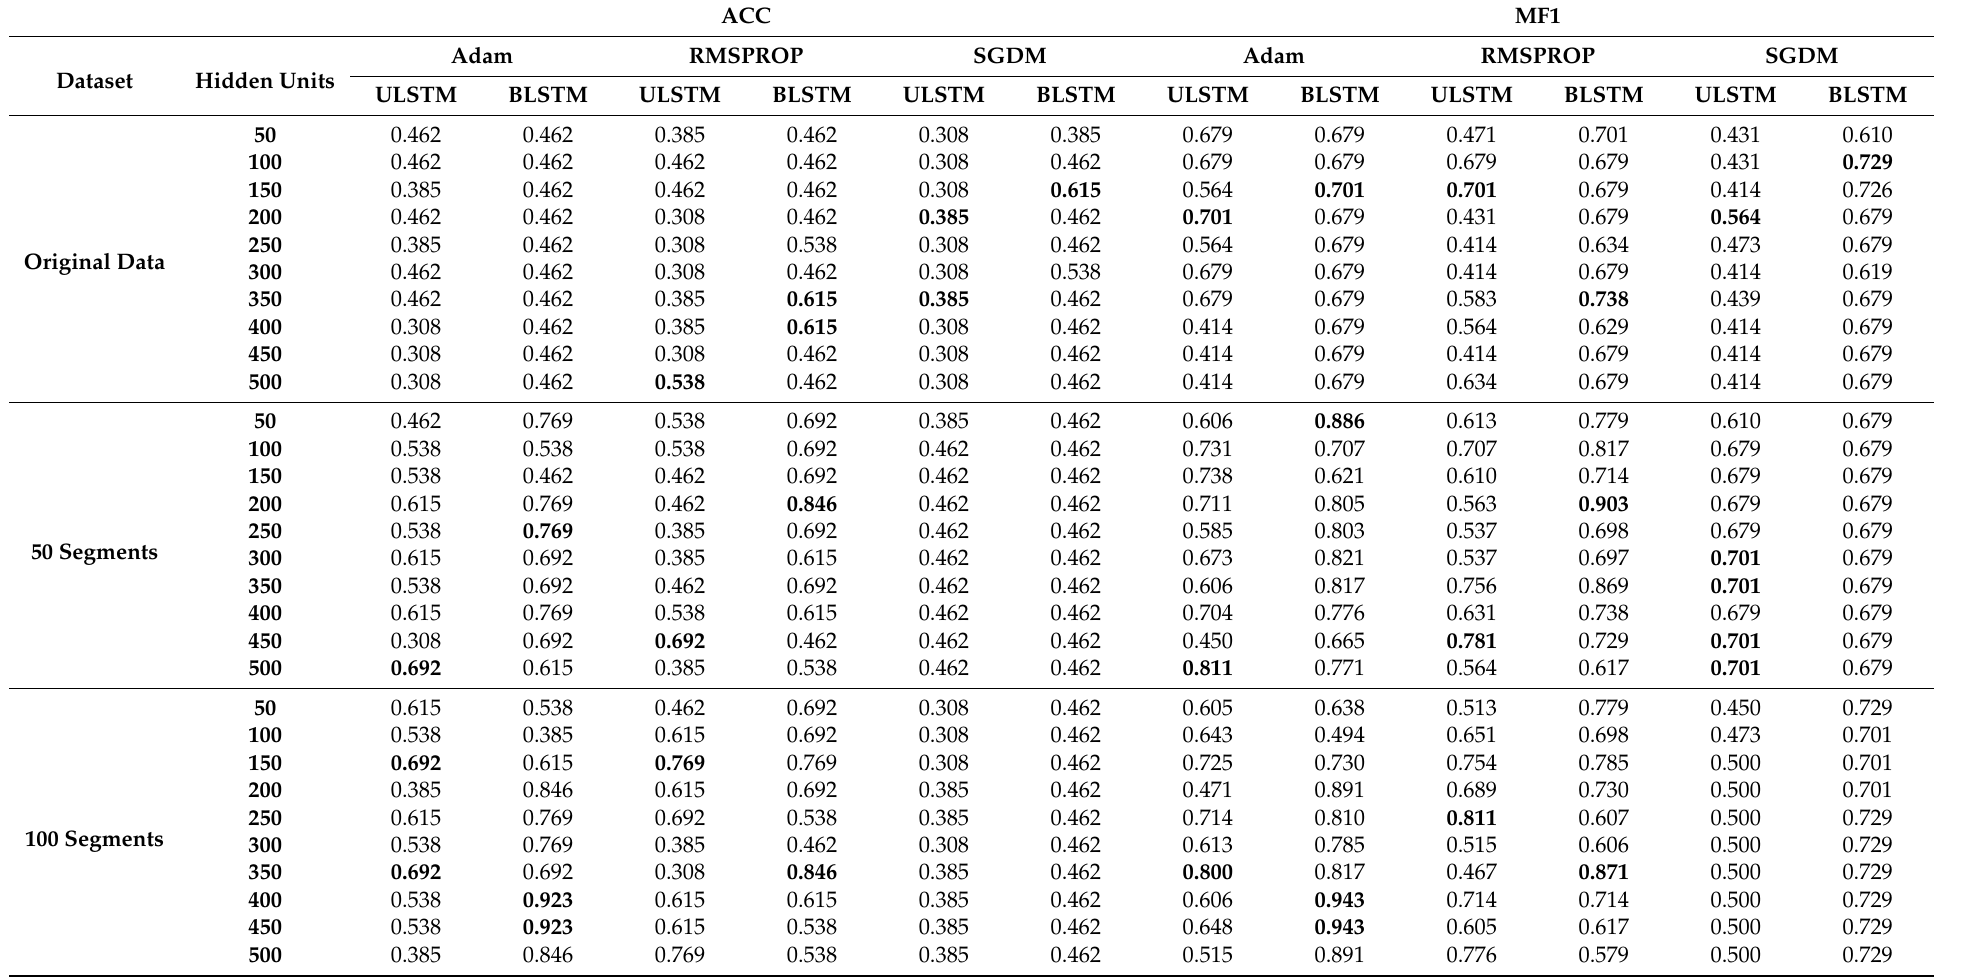
Table 9. Performance metrics of the OD test (control) data from the networks trained with the 35-mer adenosine